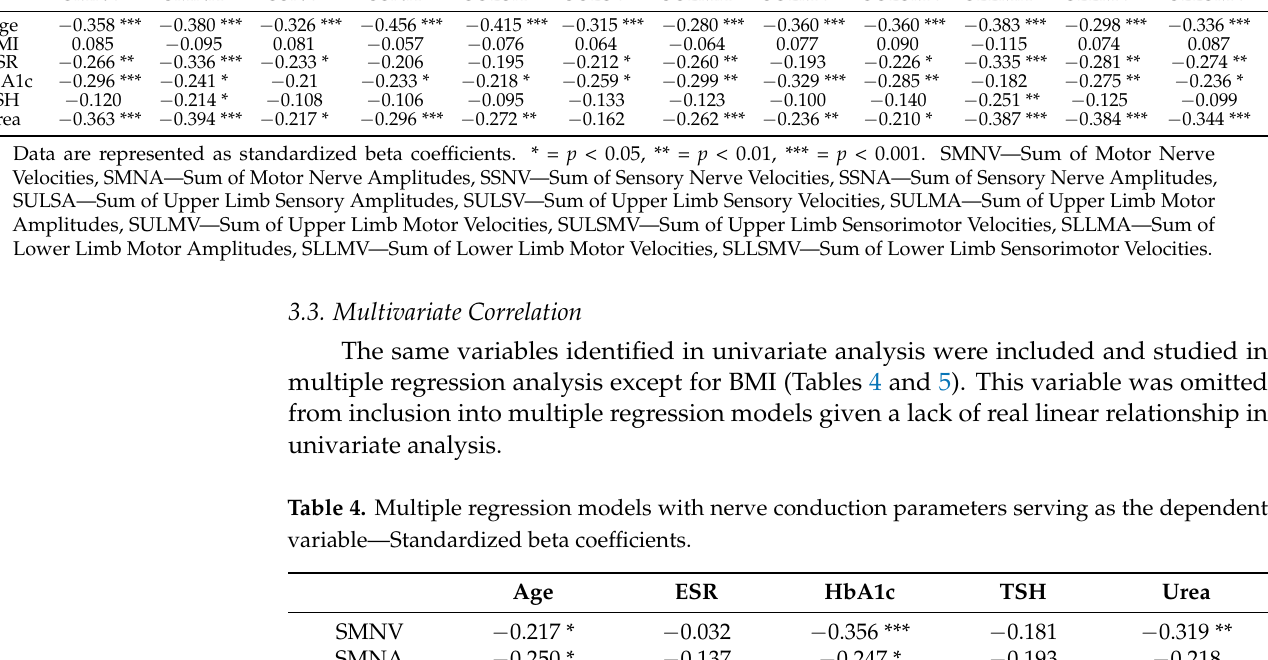
Table 3. Spearman’s correlation coefficients between nerve conduction parameters and metabolic, anthropometric variables. SMNV